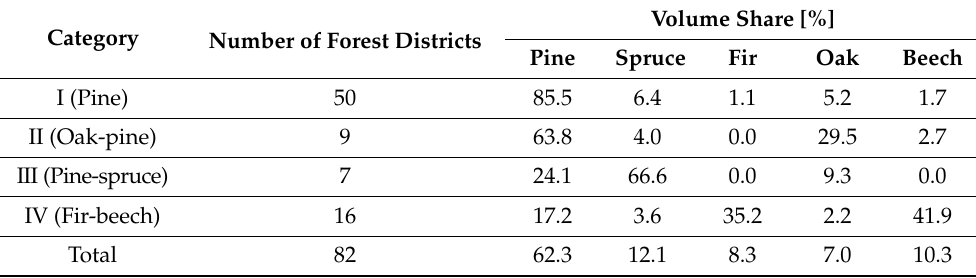
Table A4. Categories of forest districts distinguished on the basis of tree species composition.